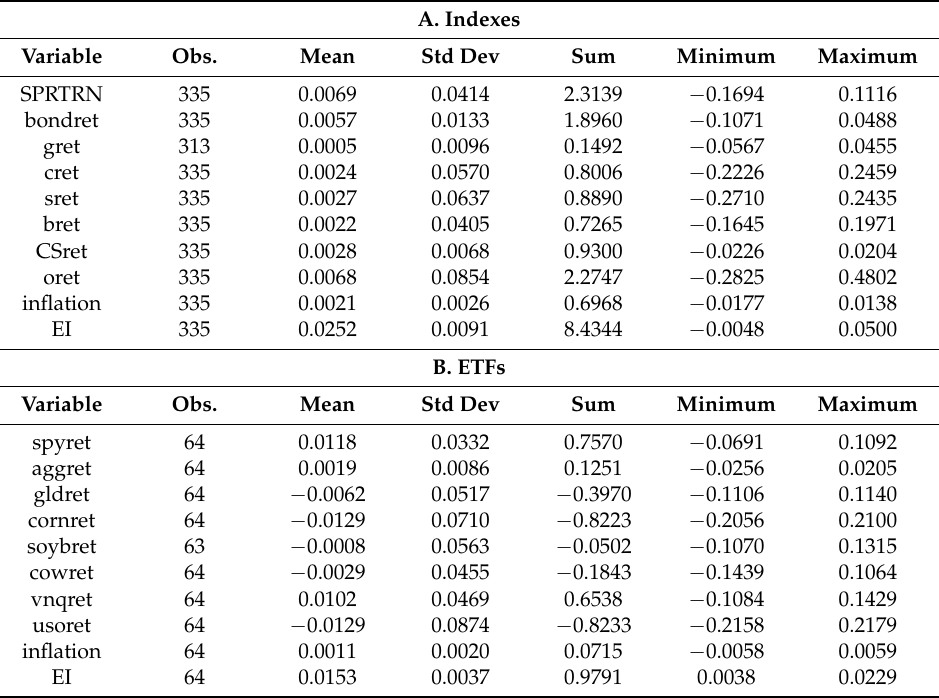
Figure 3. Inflation and oil index graph.